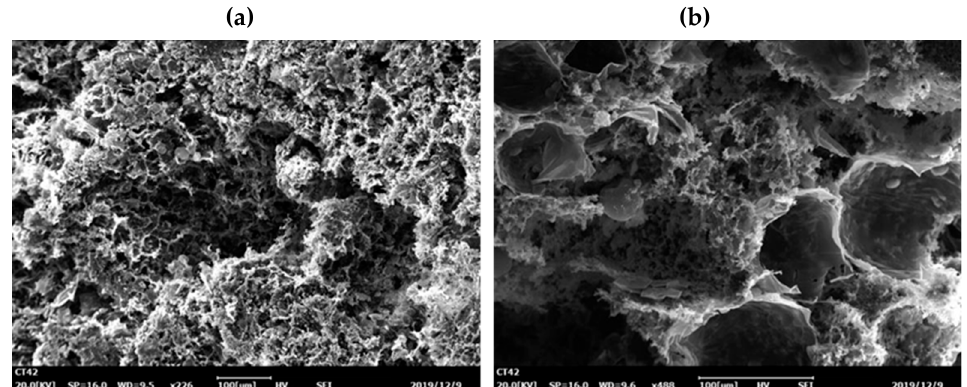
Figure 5. Morphologic characteristics of the surface and interior of the bagasse cellulose-TiO 2 carrier, obtained using SEM. ( a ) Morphologic characteristics of the surface of the bagasse cellulose-TiO 2 carrier; ( b ) Morphologic characteristics of the interior of the bagasse cellulose-TiO 2 carrier.